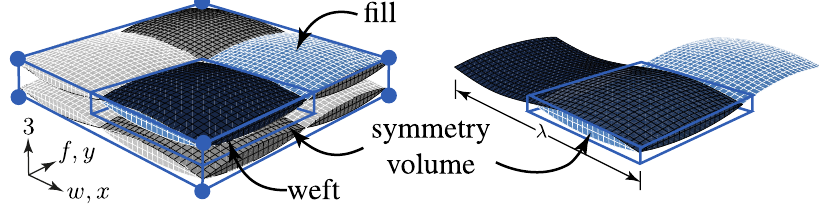
Figure 22. Illustration of assessed volume to identify the influence of the textile